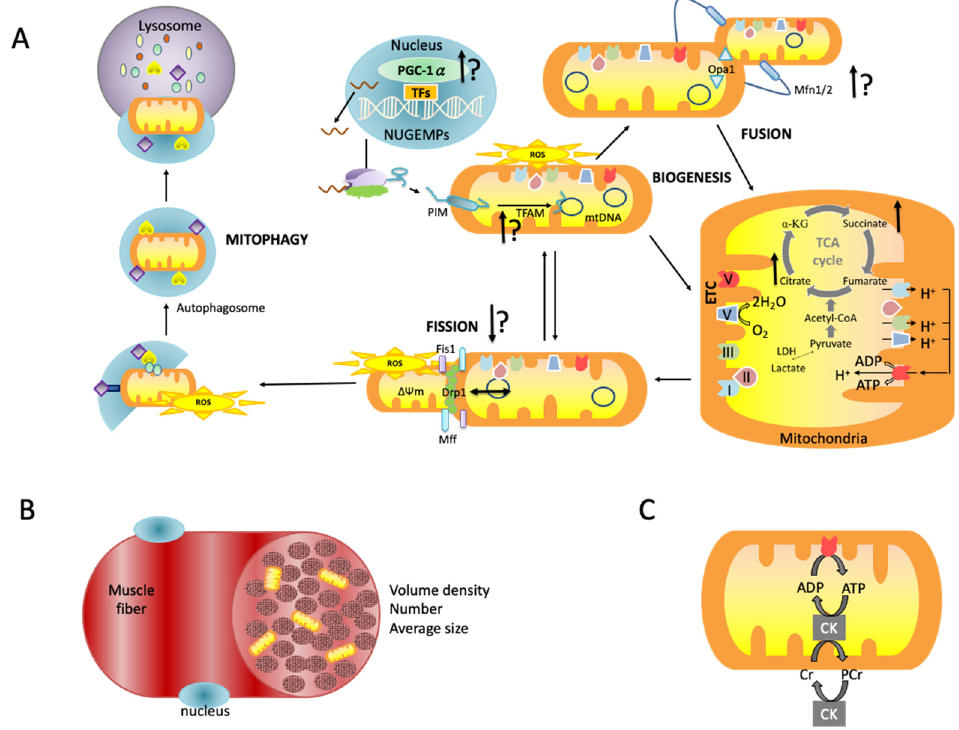
Figure 3. Illustrative diagram shows: ( A ) the mitochondrial life cycle with suggesting effect of exer- cise training; ( B ) the mitochondrial quantity in muscle cells; and ( C ) ATP synthesis. ↑ indicates ma- jority evidence of exercise-induced benefits; ↑ ? indicates some evidence of exercise-induced benefits but further evidence needed; ↔ indicates majority evidence of exercise-induced benefits.